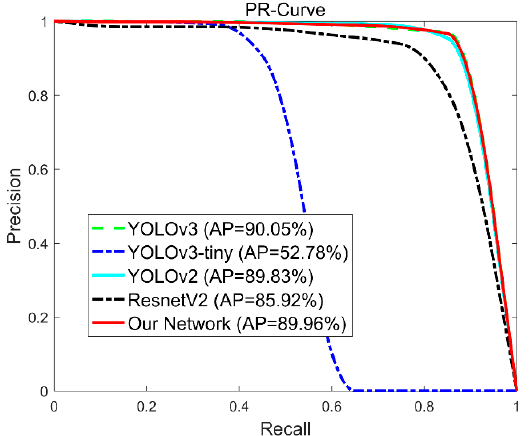
Figure 5. Figure 5. The Precision-Recall curves (PR-curves) of the proposed network and the four compared networks.